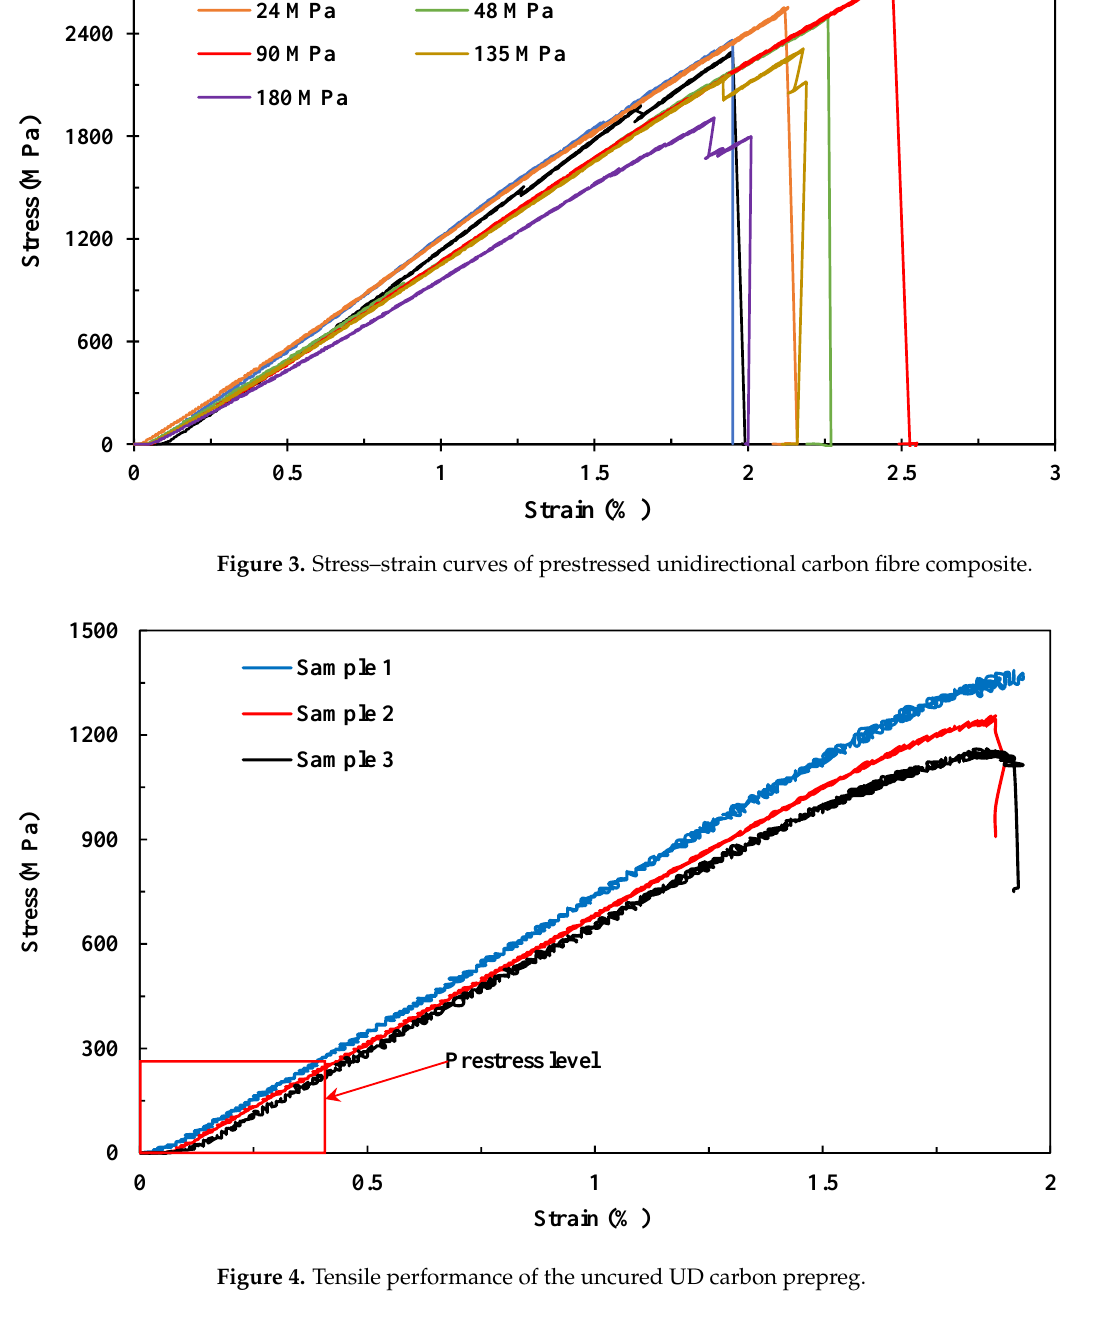
Figure 3. Tensile performance of the uncured UD carbon prepreg. Figure 4. Tensile performance of the uncured UD carbon